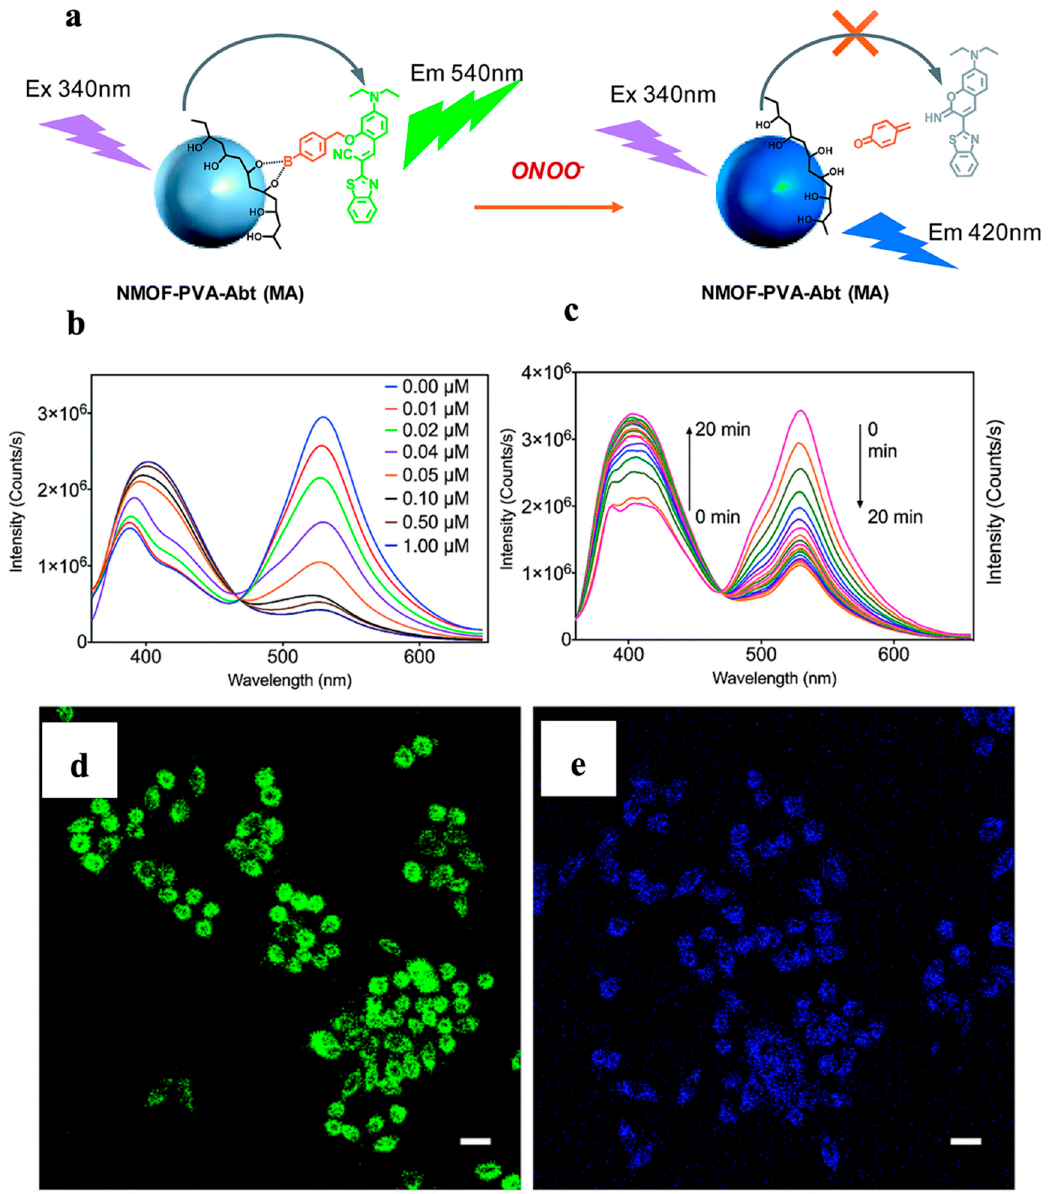
Figure 2. The sensing and cell imaging of ONOO - with NMOF-Dye FRET pair. ( a ) Schematics of the sensing mechanism. ( b ) Fluorescence spectra of MA (1 mg L − 1 ) as a function of ONOO − concentration in PBS buffer (pH 7.4) for 30 min; ( c ) fluorescence spectra of MA (1 mg L − 1 ) with the addition of 1.00 mM ONOO − over time (0 to 20 min). ( d , e ) Fluorescence microscopic images of HeLa cells for exogenous ONOO − . ( d ) The cells were stained with MA (10 mg L − 1 ) for 1 h and then washed with PBS before imaging; ( e ) the cells were pretreated as shown in ( d ) and then treated with SIN-1(1 mM) for 30 min. Scale bar: 25 mm [78]. Copyright 2017, Royal Society Chemistry.